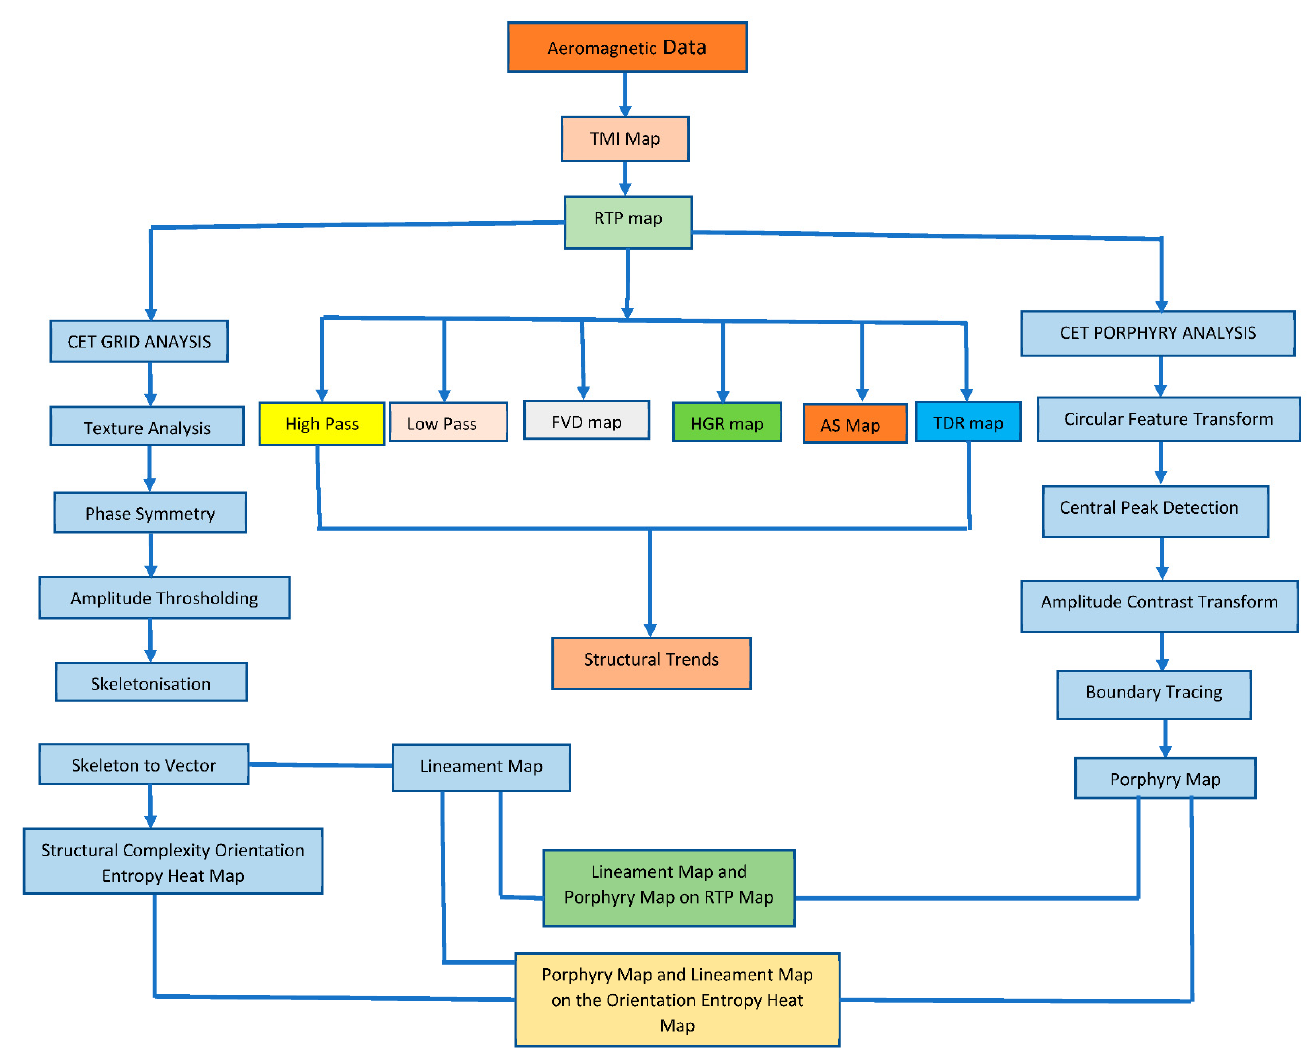
Figure 2. Methodology flow chart of the study.